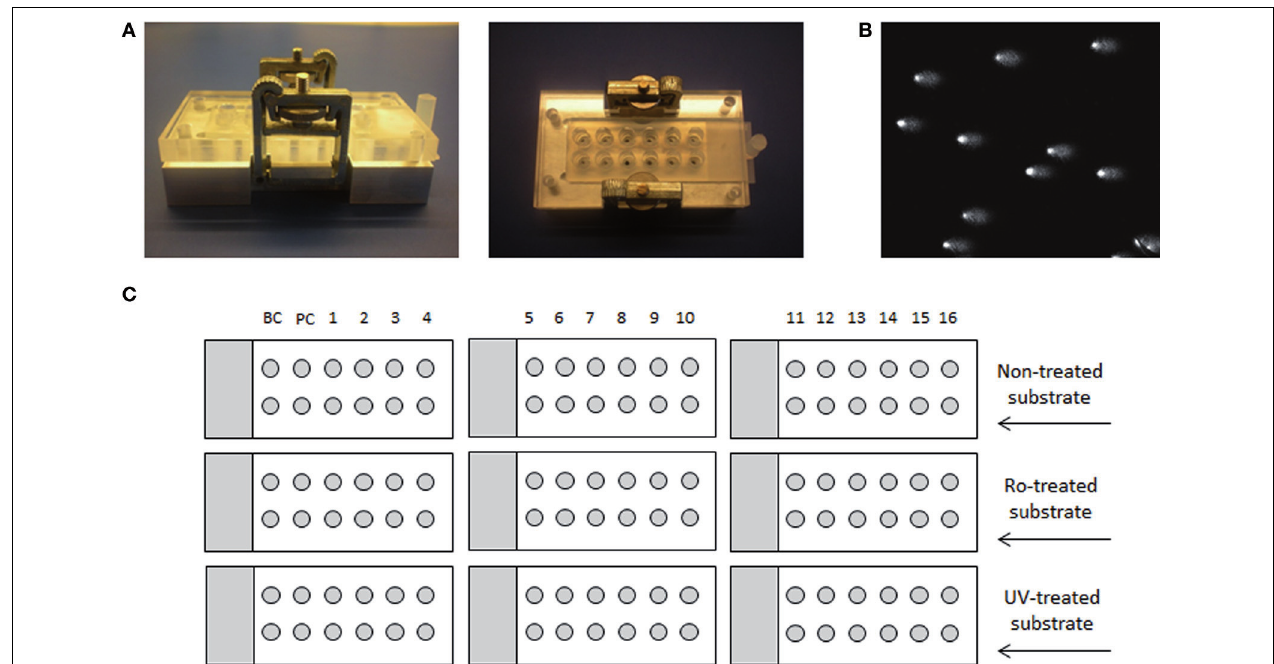
FIGURE 1 | Medium-throughput comet assay format and layout of the experiment. (A) Device for 12-minigel format, (B) image of comets, and (C) a schematic example of an experiment, using 16 different extracts, background control with buffer only (BC) and a